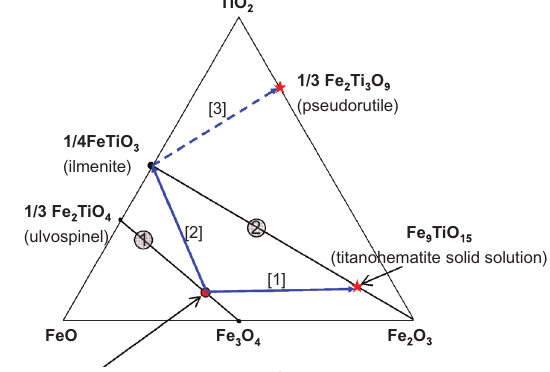
Figure 9: The ternary system of FeO-Fe 2 O 3 -TiO 2